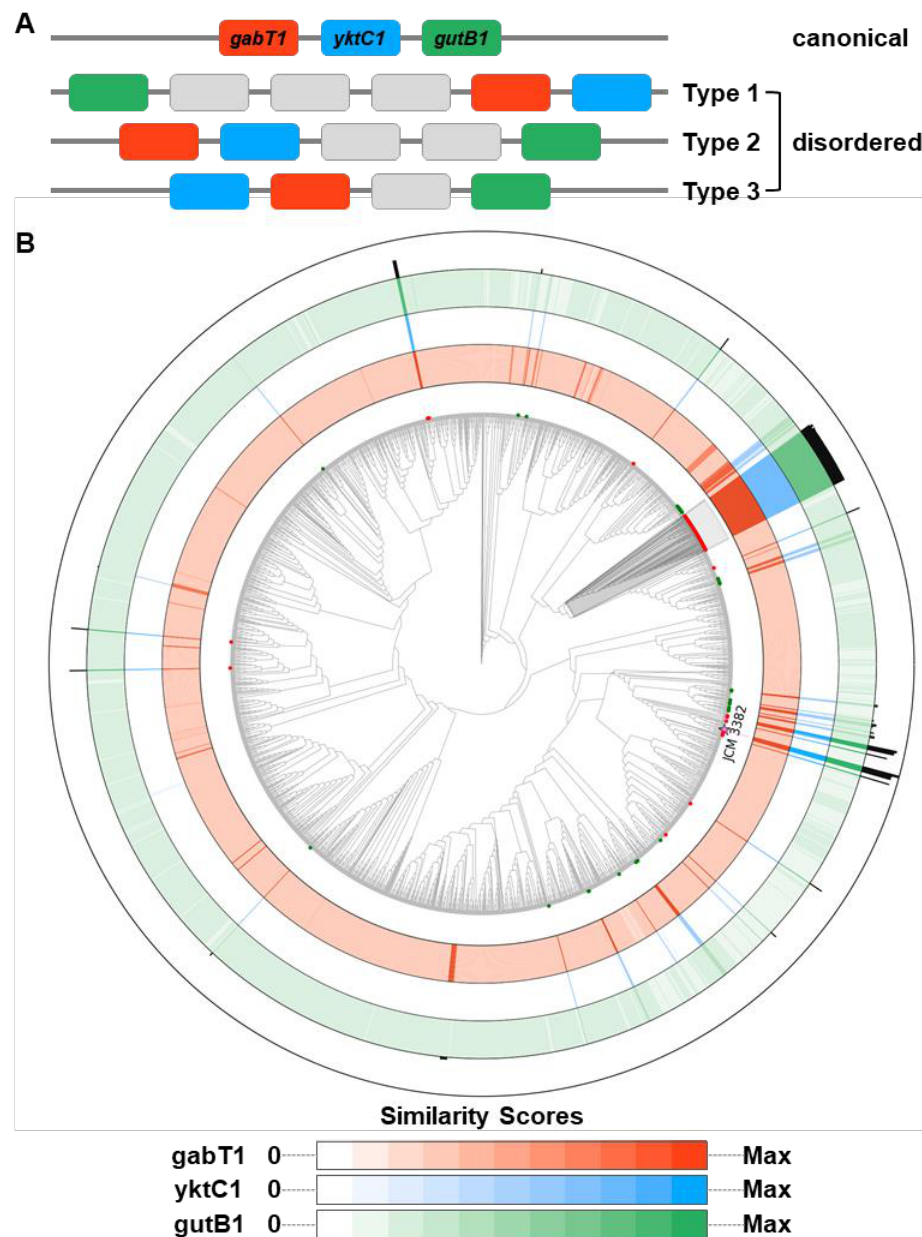
Figure 5. Distribution of the gabT1 - yktC1 - gutB1 gene cluster over a phylogenomic tree of 2062 Streptomyces genomes. ( A ) Schematic diagrams describing the gene structure. gabT1 , yktC1 , and gutB1 are indicated by red, blue, and green, respectively. Gray indicates a gene other than these three. ( B ) Distribution of the gene cluster with the phylogenomic tree shown as a cladogram. A total of 110 genomes are indicated by colors in their terminal nodes: genomes containing (i) a canonical gene cluster (red), (ii) a canonical and a disordered cluster (pink), and (iii) a disordered cluster (green). The strain JCM 3382 is indicated with a star at the terminal node. A clade shaded in gray indicates 53 closely related genomes having a canonical cluster. The sequence homologies of GabT1, YktC1, and GutB1 are shown in color gradients. The more intense the color, the more homologous genes found in the corresponding genome. Homology was measured using the formula −log 10 (E-value). An E-value of 0 was replaced with 1e −200 to avoid infinity. The homology of the nucleotide sequences of the whole gene cluster was calculated as the sum of significant hits (E-value <1e −20 ) and is shown as a histogram. From the outermost track: the whole gene cluster, GutB1, YktC1, and GabT1.